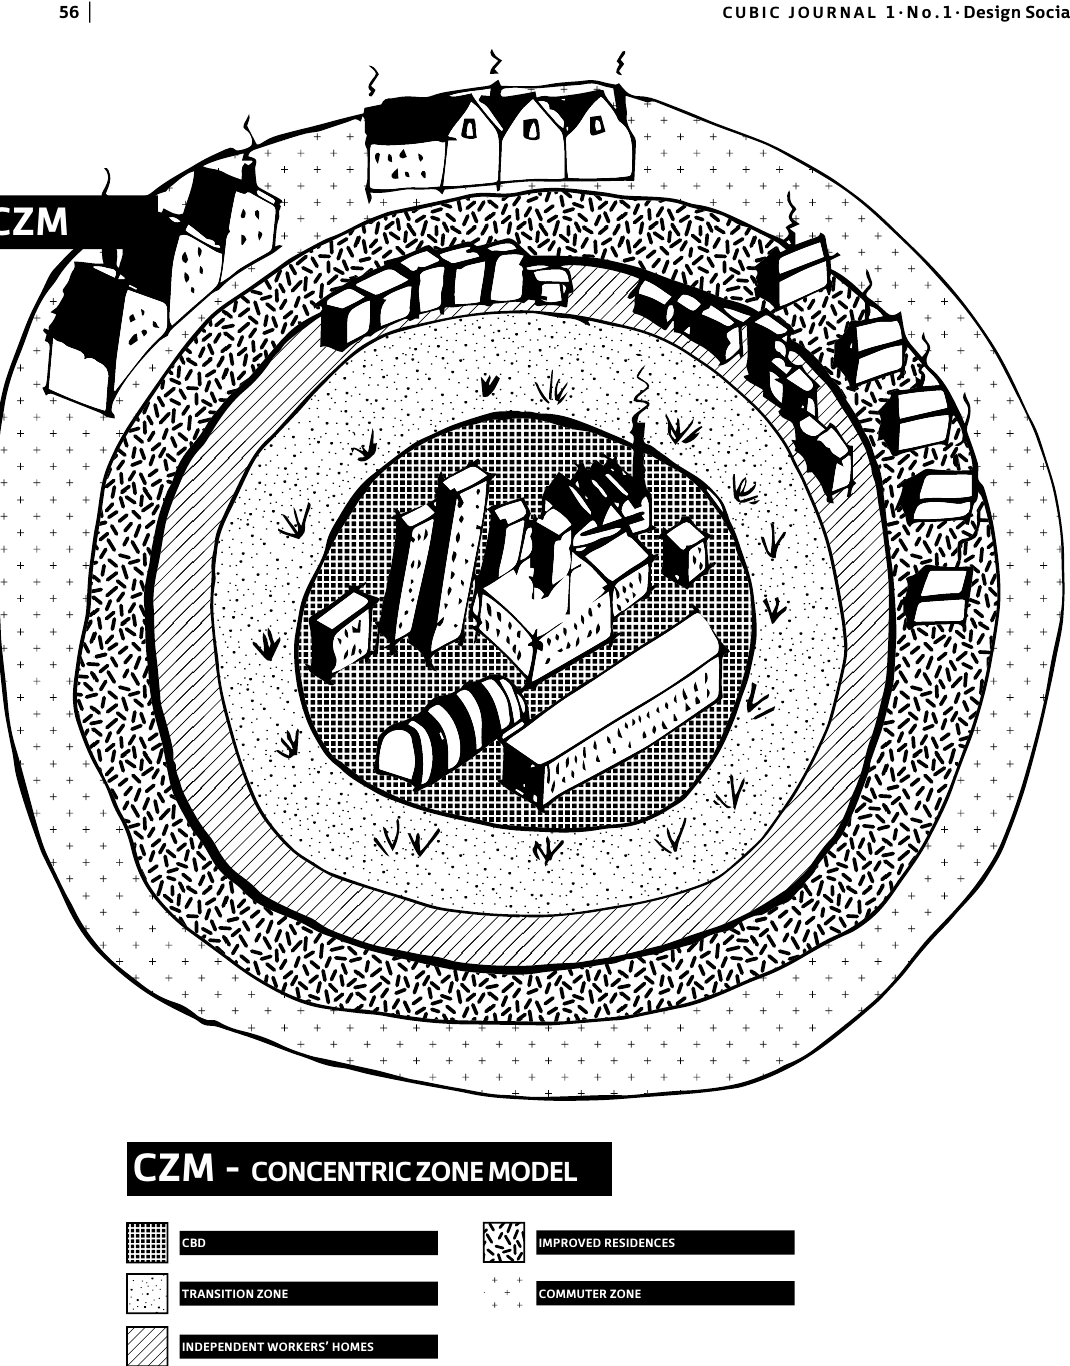
Figure 1 (top, this page): Social-spatial urban forms after Burgess' Concentric Zone Model (CZM). Mixed media drawing. Source: Author. Figure 2 (page 57, top): Social-spatial structure after Hoyt's Sectoral Model (SECM). Mixed media drawing. Source: Author.